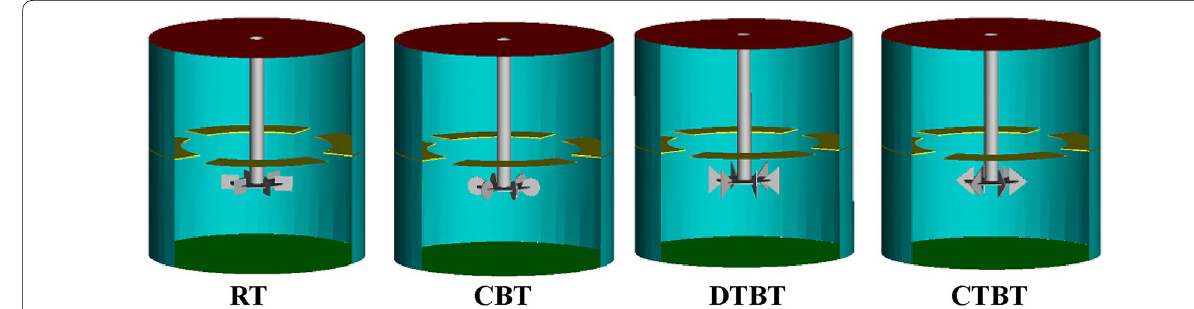
Figure 20 Stirred vessel configurations with CHCB for an angle 20°